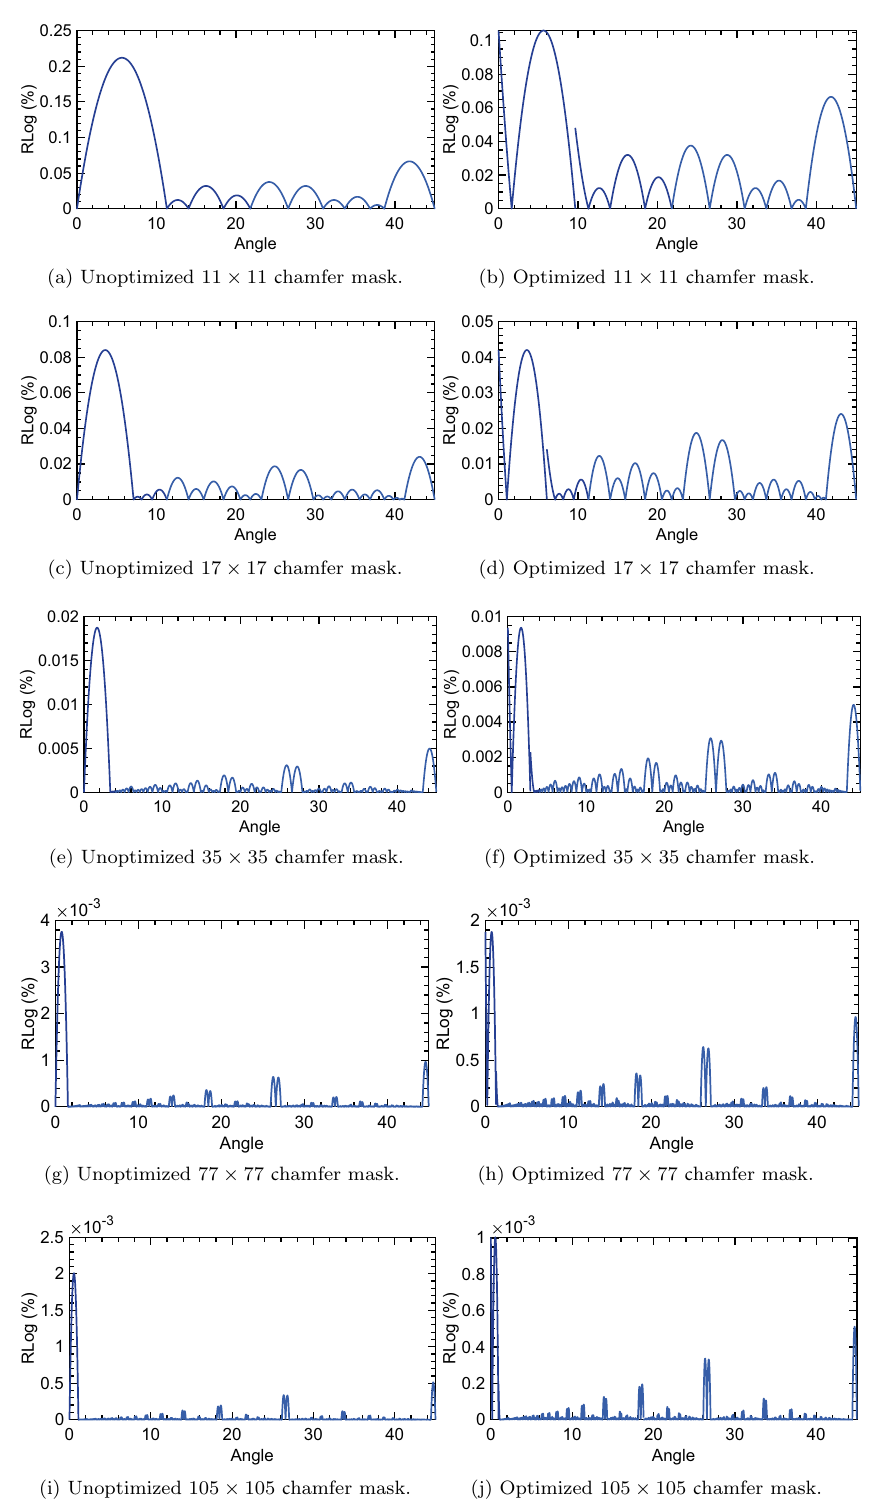
Figure 4. RLog Error lobes generated by high-order chamfer